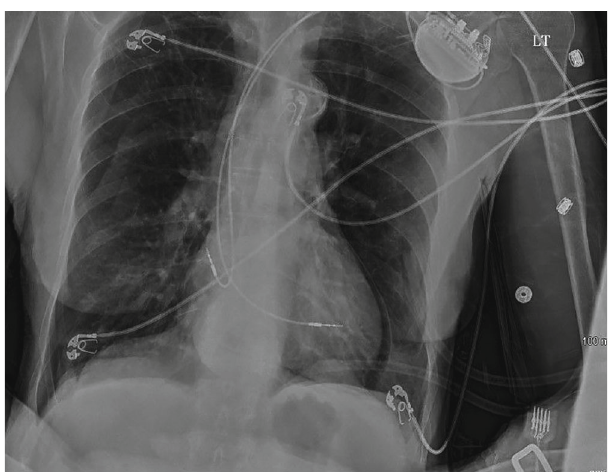
Figure 1: Anteroposterior chest radiograph revealing pneumopericardium.